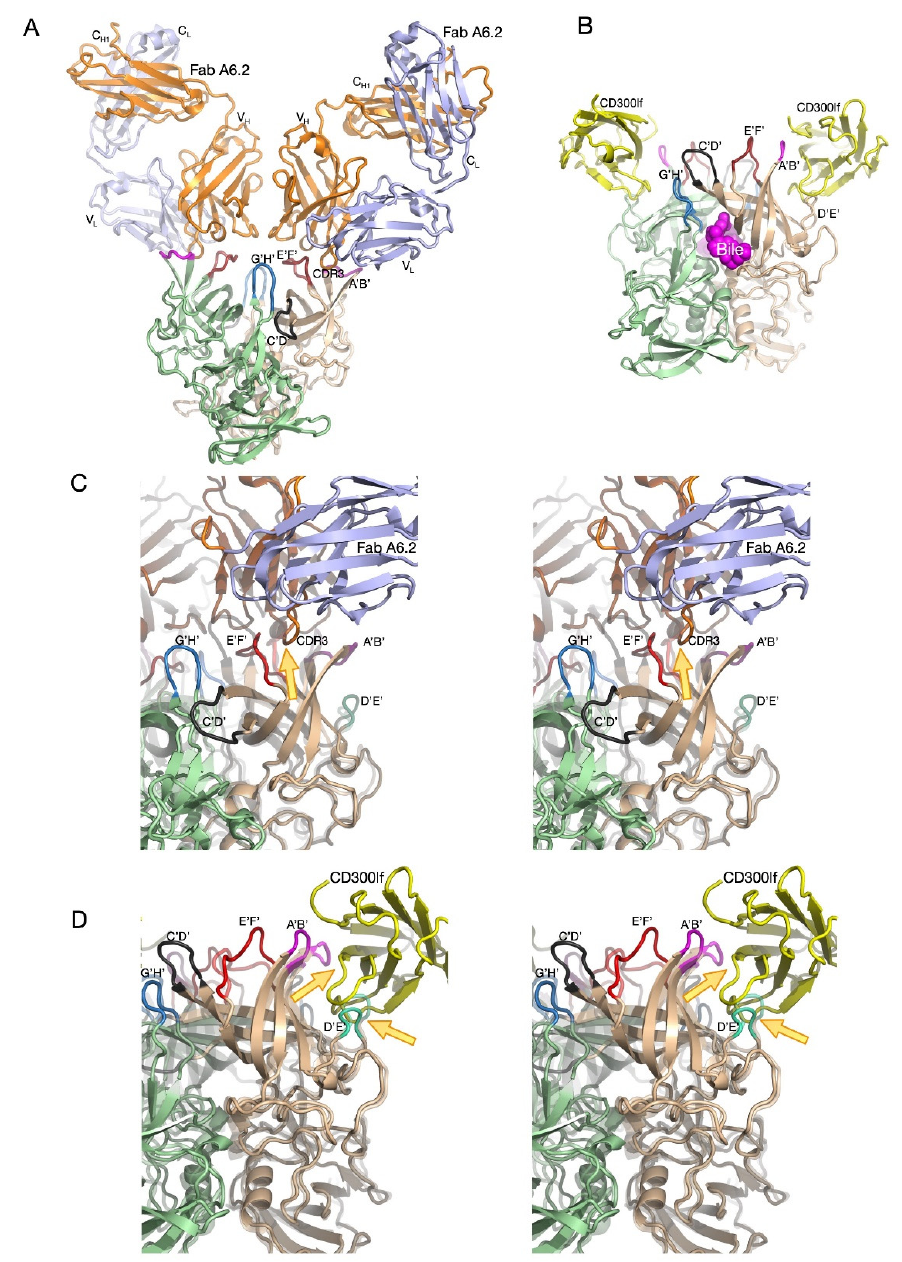
Figure 3. High-resolution structures of MNV-1 P domain complexed with a neutralizing antibody (A6.2) and the receptor CD300lf. ( A ) The ~3 Å cryo-EM structure of the isolated P domain complexed with neutralizing Fab A6.2 [37]. The two P domains are colored tan and light green and the antibody heavy and light chains are colored orange and light blue, respectively. The loops at the tip of the P domain, A’B’, C’D’, E’F’, and G’H’, are colored mauve, red, black, and blue, respectively. Note that the P domain is in the open conformation and that the CDR3 loop of the antibody reaches down between the A’B’ and E’F’ loops. ( B ) The crystal structure of the P domain complexed with GCDCA and the receptor CD300lf [23]. The color scheme of the P domain is the same as in ( A ) and CD300lf is shown in yellow. ( C ) Stereo figure of the Fab A6.2 bound to the open conformation of the P domain. The transparent image is the structure of the P domain in the closed conformation. The yellow arrow highlights the structural clashes between Fab A6.2 and the closed P domain structure. ( D ) Stereo figure of the P domain/CD300lf complex. With the transparent ribbon diagram of the P domain from the Fab complex.